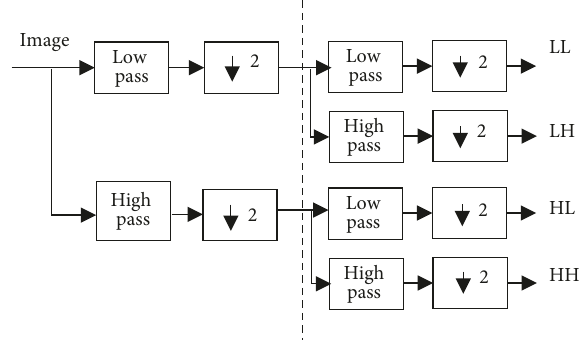
Figure 6: The structure of forward two-dimensional